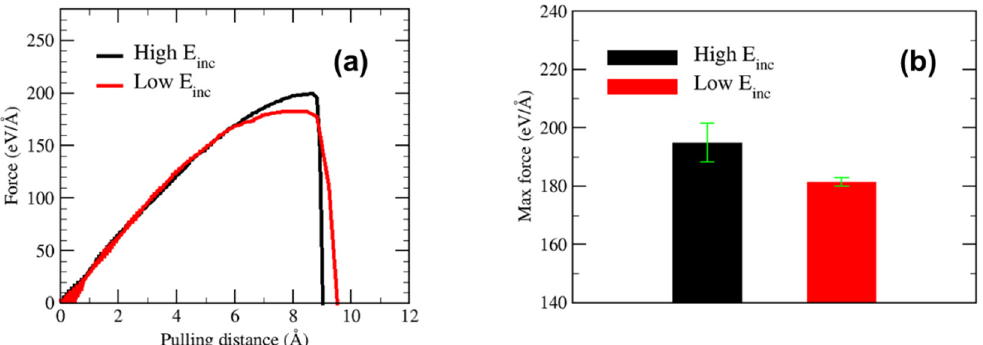
Figure 7. Comparison of adhesion force between high and low E Inc cases: ( a ) evolution of pulling force as a function of pulling distance ( b ) level of maximum pulling